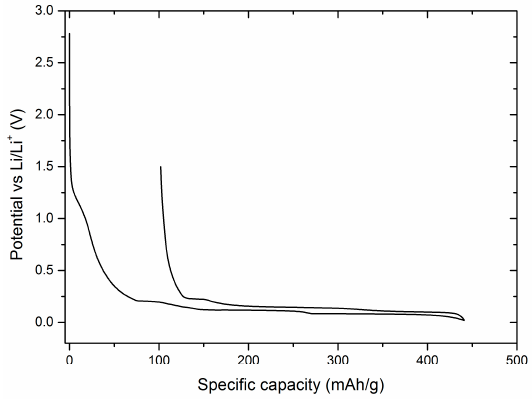
Figure 4. First cycle potential profile of graphite/Li cell containing 1 M LiPF 6 in EMS:EA (1:1) + 4% FEC electrolyte, in the potential range from 0.02 to 1.5 V vs. Li/Li + .